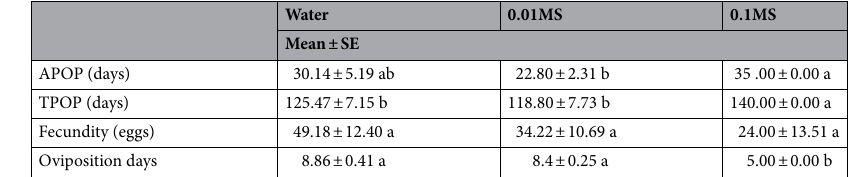
Table 2. Adult preoviposition period (APOP), total preoviposition period (TPOP), fecundity, and oviposition days of Acanthococcus lagerstroemiae reared on Lagerstroemia under different nutrient conditions. Values are means ± standard errors; data within a row followed by different letters are significantly different at p < 0.05 by using paired bootstrap